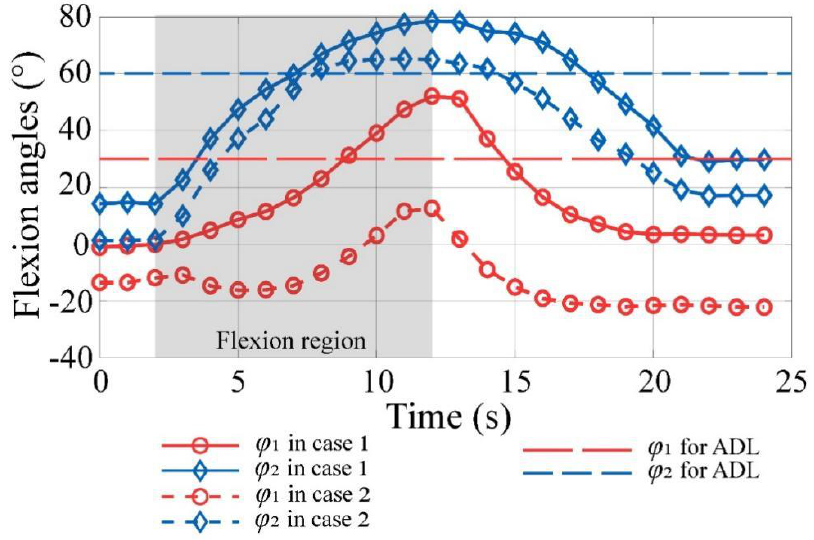
Figure 11. Results of finger flexion angle of different passive stretching forces.